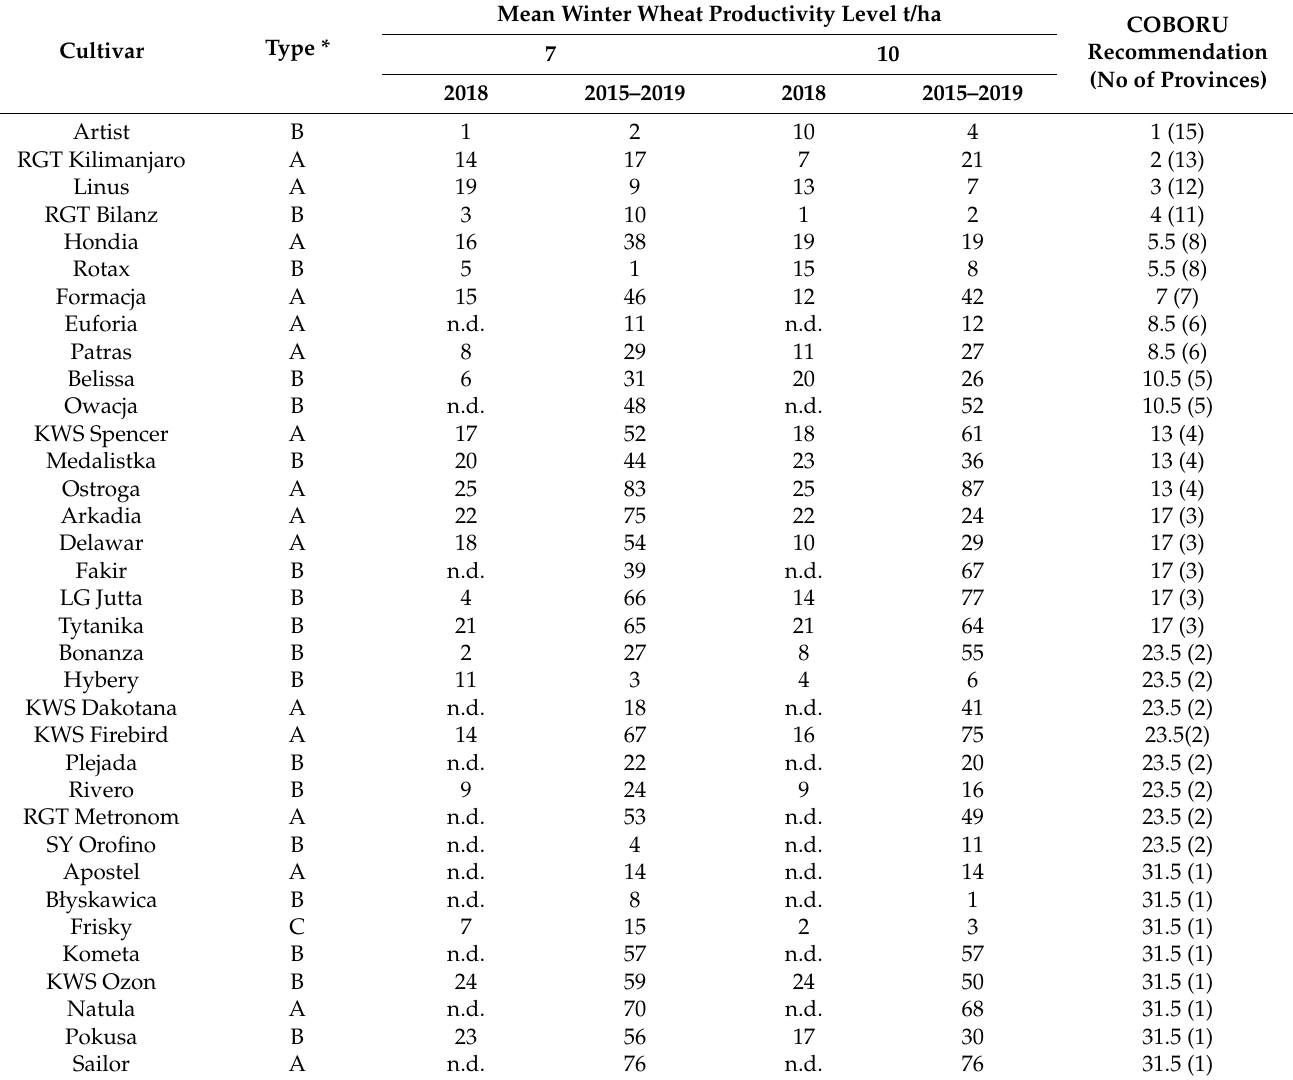
Table 5. List of winter wheat cultivars recommended by COBORU [4] with their place in the ranking of estimated yield in environments based on the period and mean productivity